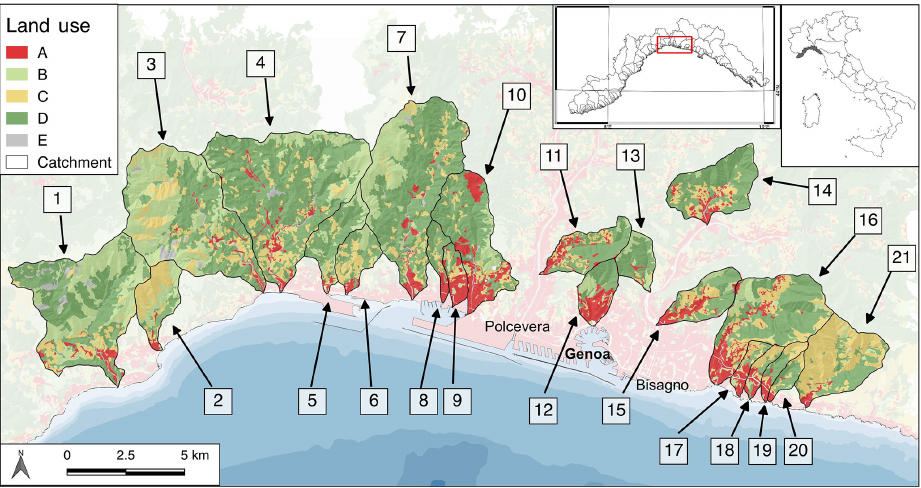
Figure 1. Land use of the studied catchments (ref. to Table 1). A: urban area; B: meadows; C: cultivations; D: woods; E: rocks and areas hit by